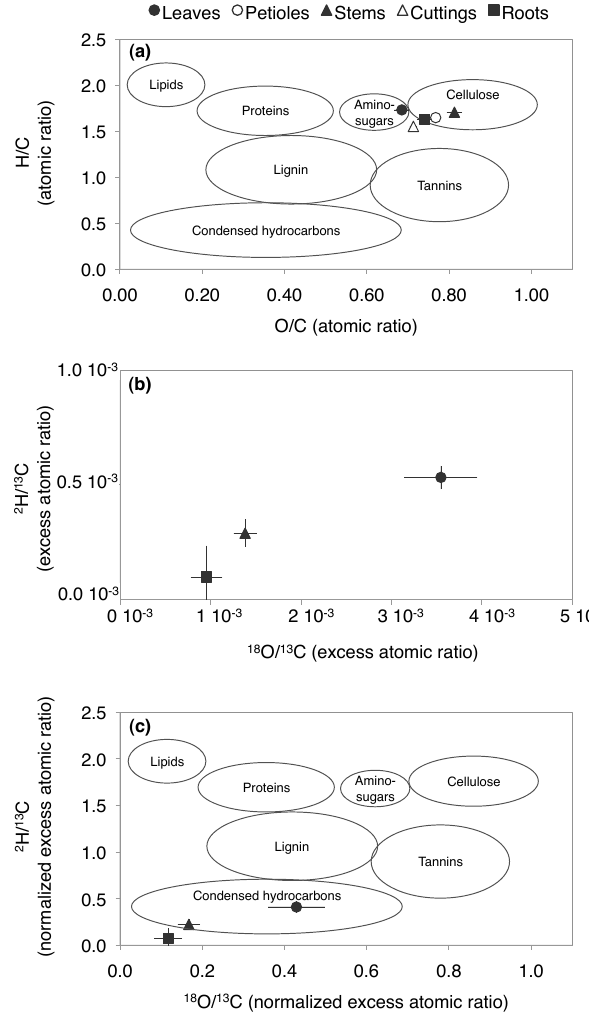
Figure 3. Atomic and isotopic ratios to illustrate change in OM characteristics. (a) Atomic and (b, c) isotopic ratios of oxygen and hydrogen to carbon within the leaves (black circles), petioles (white circles), stems (black triangles), stem cutting (white triangles) and roots (black squares). The circles overlain on the plots in (a) and (c) indicate atomic ratios characteristic for different compound classes (adapted from Sleighter and Hatcher, 2007). Panel (a) illustrates the atomic ratio of all tissues measured (15 replicates ± 1 standard de- viation, panel (b) the isotopic ratios of the 13 C, 18 O and 2 H ex- cess atom fraction (relative to the unlabelled tissues) measured after equilibrium in the labelling (see Fig. 1 and 2) was reached ( t = 8 and 14, six replicates ± 1 standard deviation) and panel (c) shows the isotopic ratios after normalization with the maximum label strength detected in the leaf water ( 18 O, 2 H) and water-soluble OM ( 13